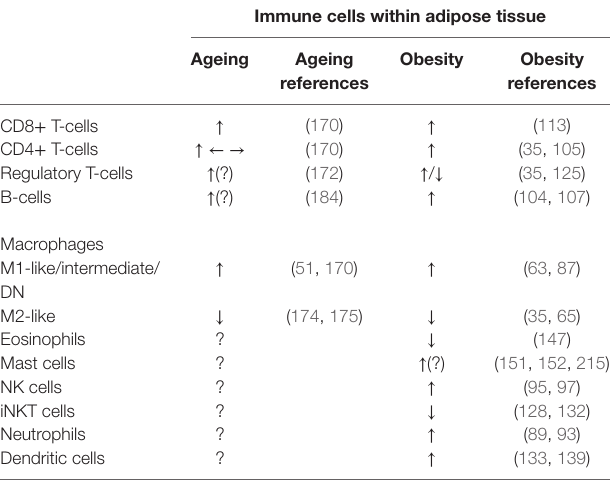
TABLe 6 | Changes in the expression of proteins within adipose tissue (adipocytes and cells of the stromal fraction) with age and obesity compared to young and lean, respectively.